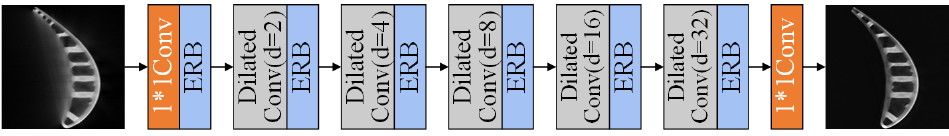
Figure 12. The structure of the Dilated Residual Network for turbine blade ICT images artifact